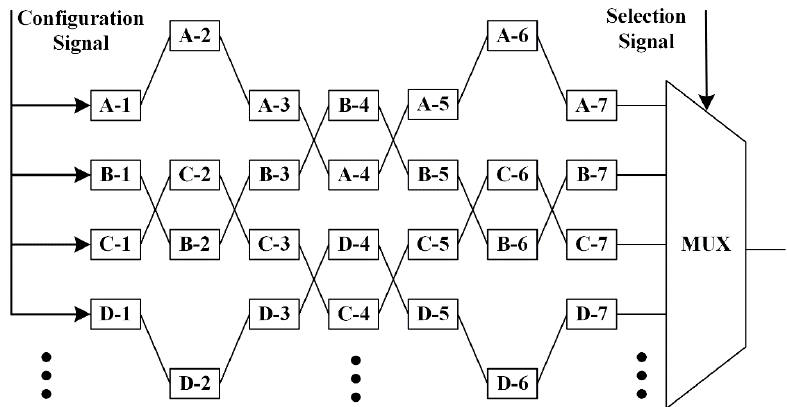
Figure 7. Architecture of the anti-electromagnetic (EM) attack CRO PUF.